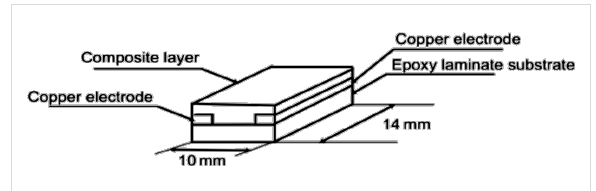
Figure 1: Schematic structure and dimensions of an EVA–CB sample. Reproduced with permission from [20], copyright 2011 Versita Warsaw and Springer-Verlag